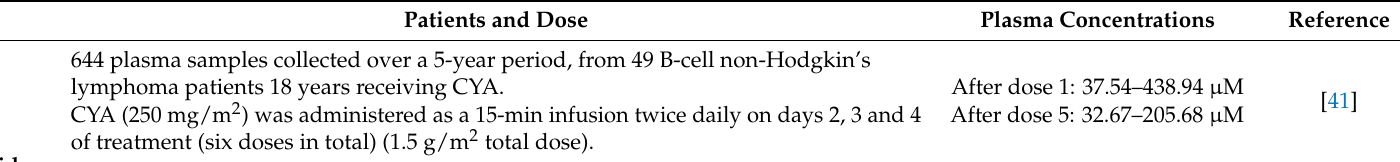
Table 1. Plasma levels observed after doxorubicin (DOX), cyclophosphamide (CYA) or 5-fluorouracil (5-FU)